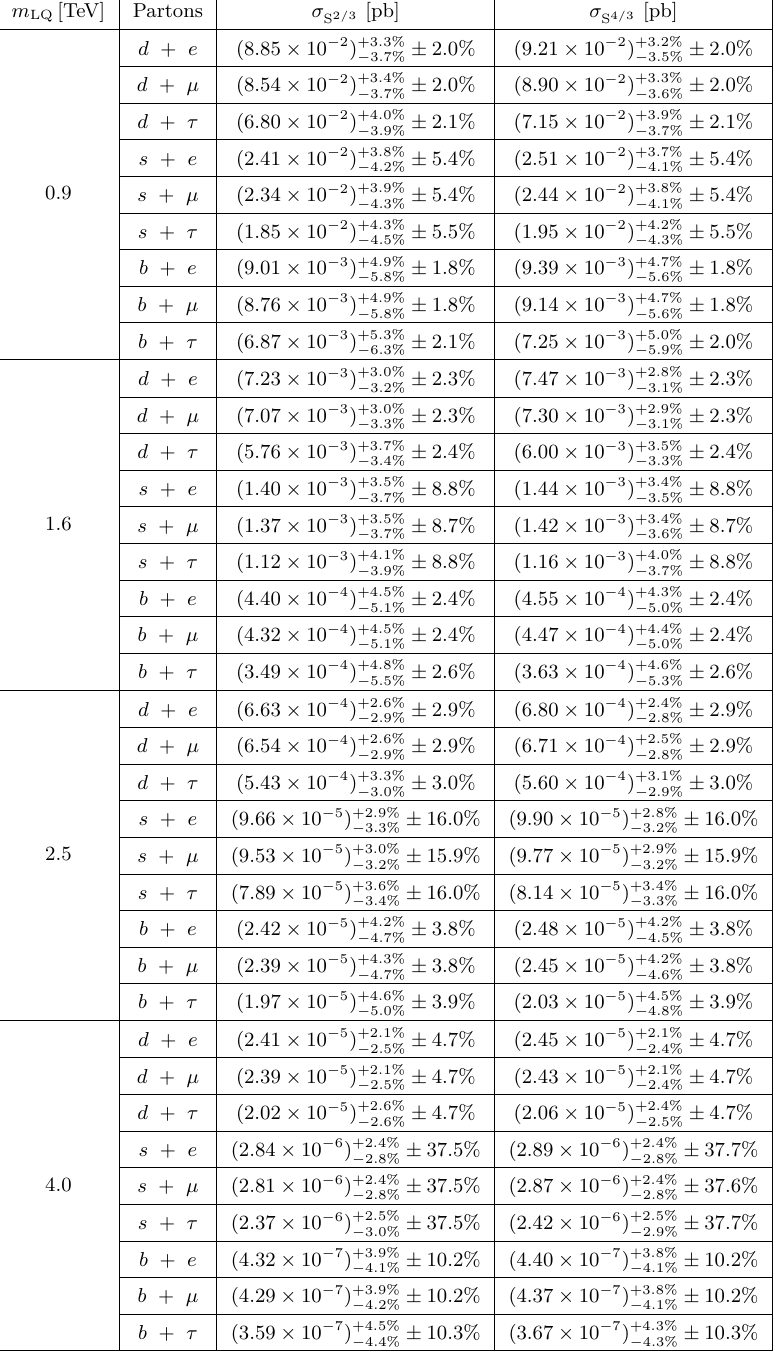
Table 2 . Inclusive cross sections in pb for the resonant leptoquark production from down-type quarks, pp → LQ + charge-conjugated process, as a function of the leptoquark mass m LQ at √ s = 13 TeV. The cross section σ ( σ ) corresponds to the resonant production of scalar S 2 / 3 S 2 / 3 LQ with absolute electric charge 2 / 3 (4 / 3) when the associated Yukawa coupling strength is set to one, y q‘ = 1 . The second column denotes which quark-lepton pair couples to the corresponding leptoquark. First (second) uncertainty is due to the renormalisation and factorisation scale varia- tions (PDF replicas), and is given in per cent units. See section 3 for